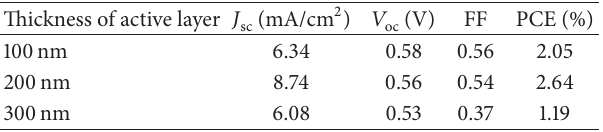
Table 1: Photovoltaic parameters of the devices with differ- ent active layer thicknesses, measured under 100mW/cm 2 illu- mination (AM 1.5G). The structure of the devices is ITO/ PEDOT:PSS/P3HT:PC 70 BM/Al.